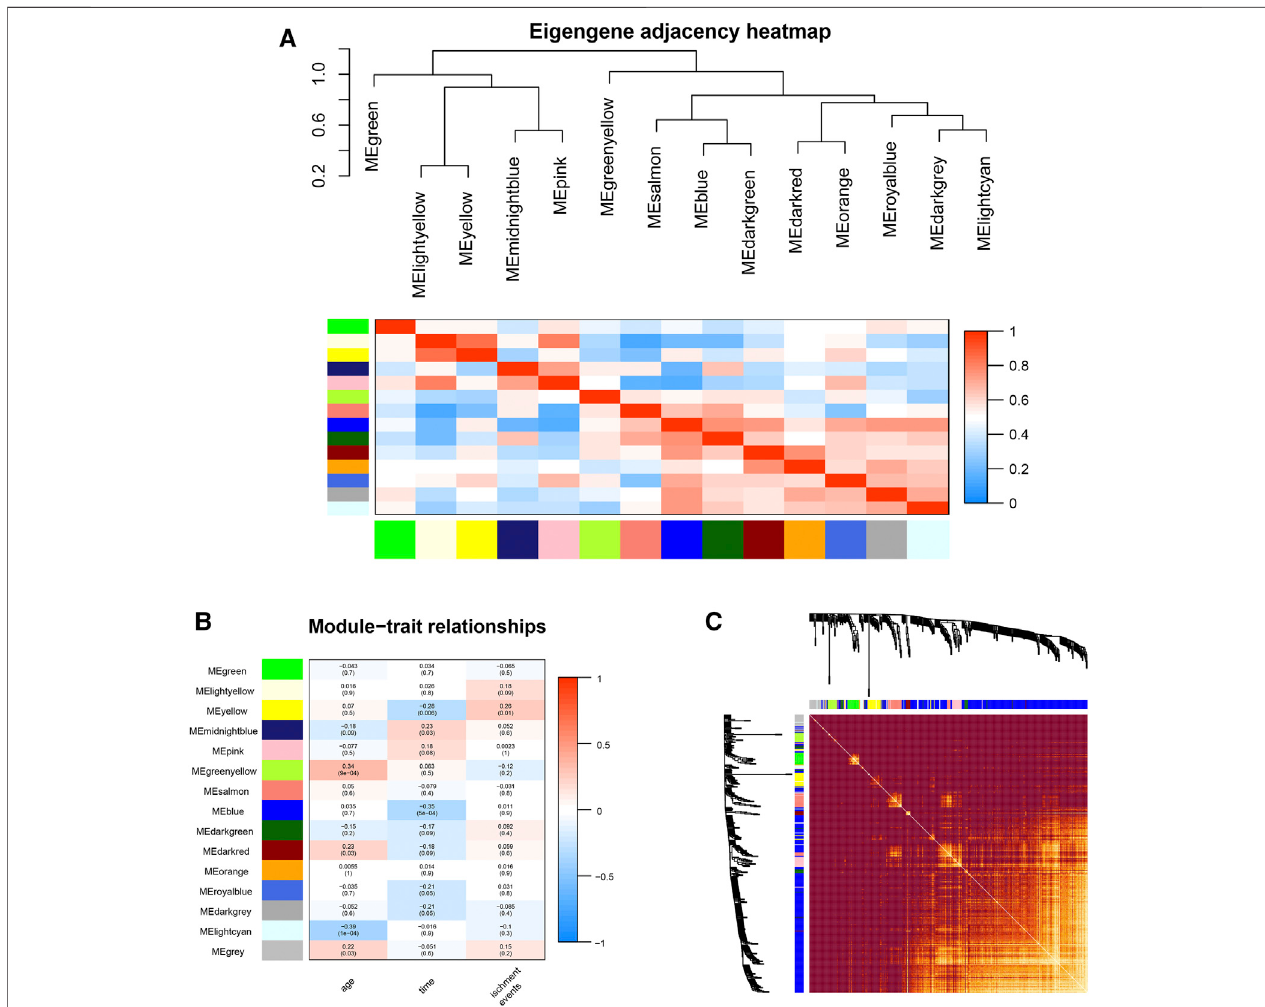
FIGURE3| GenemoduleanalysisbasedonWGCNA. (A) :Heatmapoftheeigengeneadjacency. (B) :Heatmapbetweengenemodulesandclinicalcharacteristics. (C) : Heatmap of the topological overlap matrix of genes selected by WGCNA.